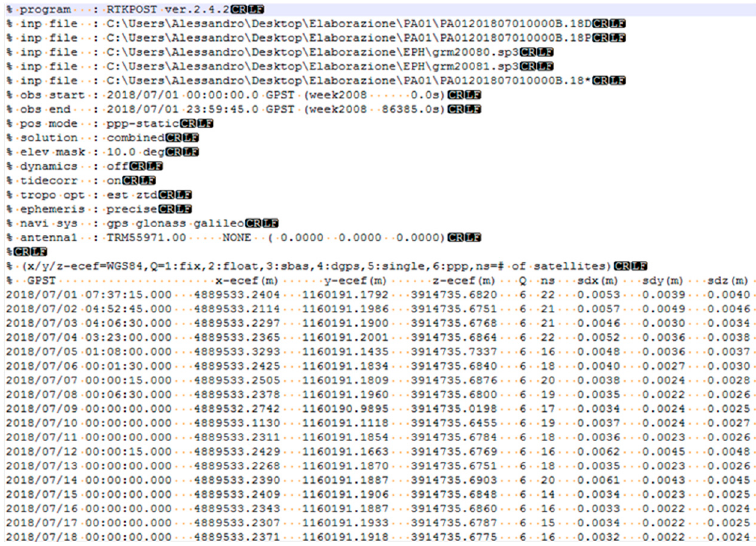
Figure 3. Example of obtained solution extract with the RTKPOST module.